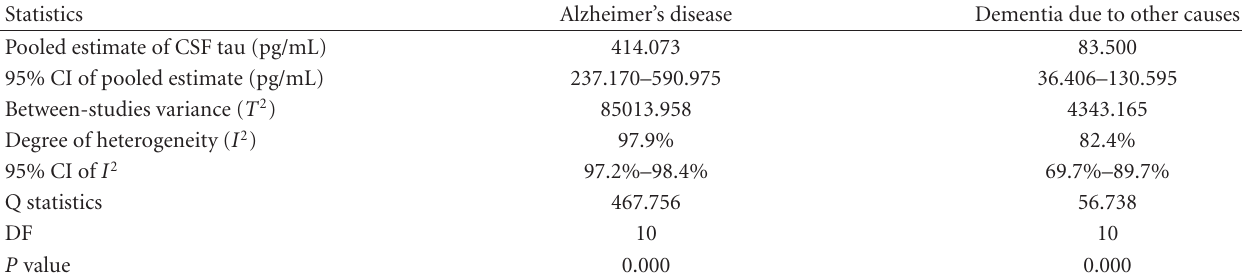
Table 3: Pooled estimate of e ff ect size with 95% CI, test of significance and magnitude of heterogeneity of CSF tau studies in Alzheimer’s disease and Dementia due to other